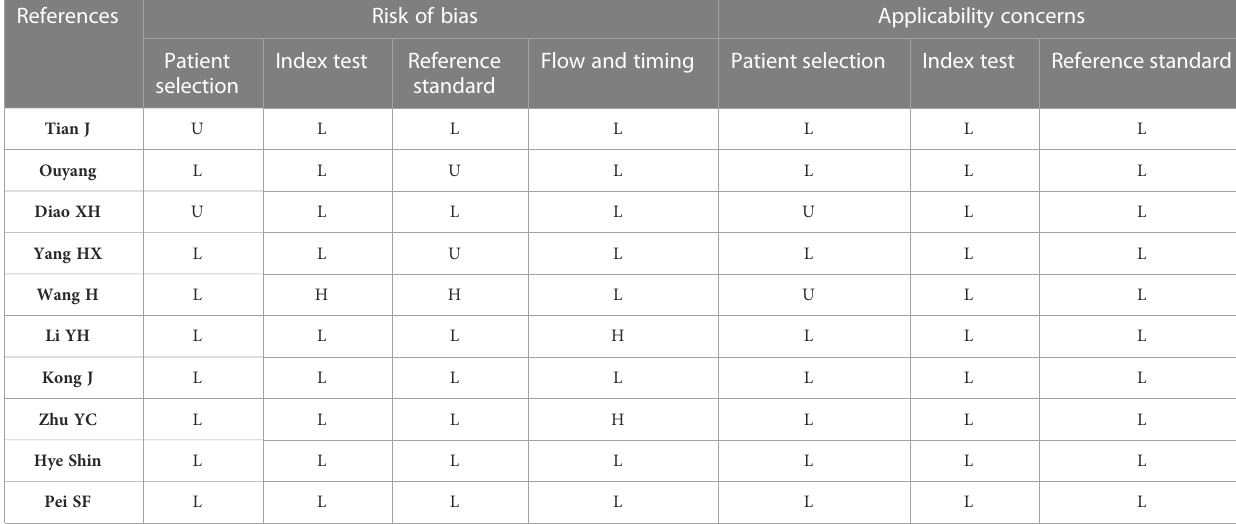
TABLE 2 Quality assessment of the included studies using QUADAS-2